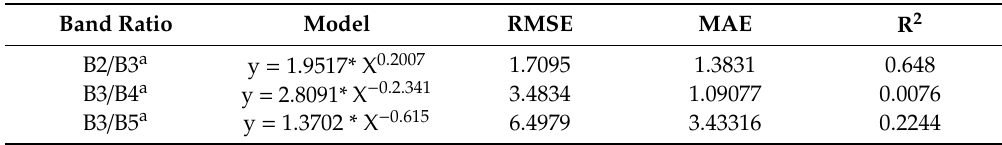
Table 7. The best-performing a(420) CDOM retrieval model estimated from the validation subset after atmospheric correction ( a ) and removal of outliers (n = 5). The variable X denotes the band ratio in the model equation.